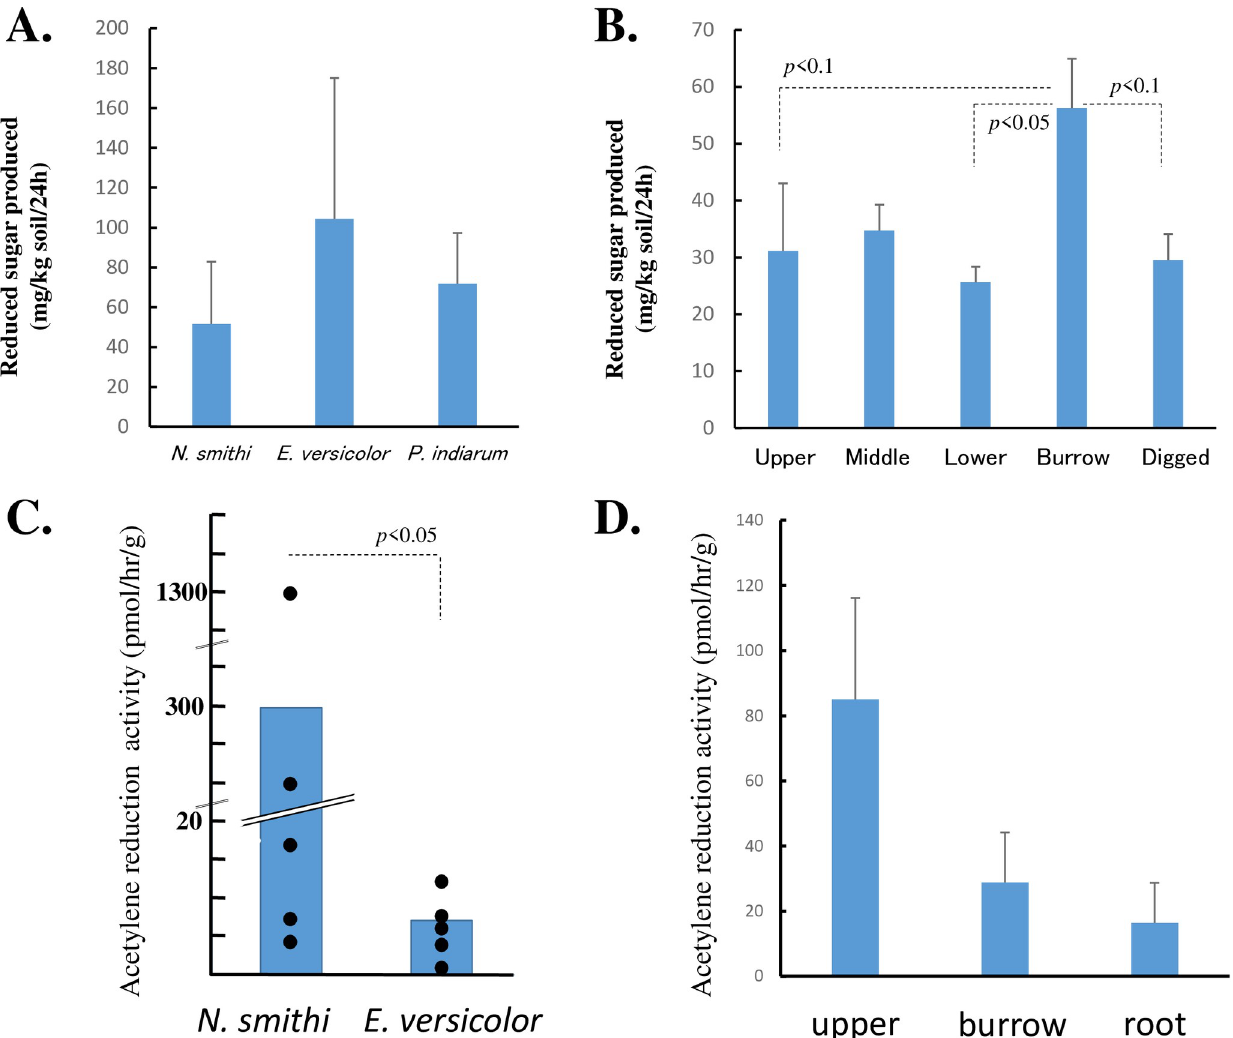
Fig 6. Cellulase and nitrogenase activities of the sediment and mangrove intestinal bacteria. A) Cellulase activity in crab intestines. B) Cellulase activity in sediment regions. C) Acetylene reduction activity in crab intestines. D) Acetylene reduction activity in sediment regions.